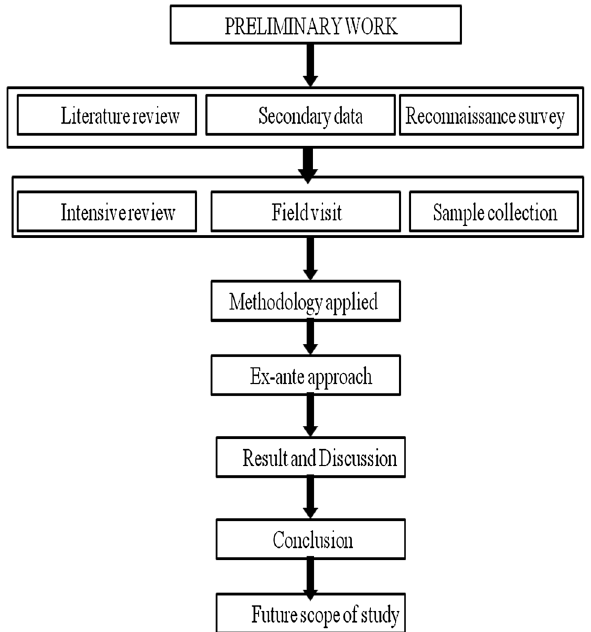
Fig. 2 Flowchart showing ex-ante approach during the preliminary